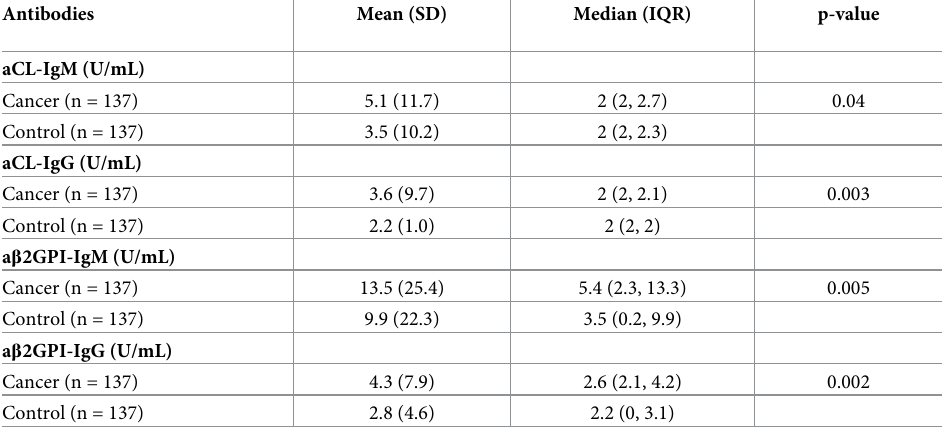
Table 3. Titers of antiphospholipid antibodies (aCL IgG and IgM and β 2GPI-IgG and IgM) in cancer patients VS controls.